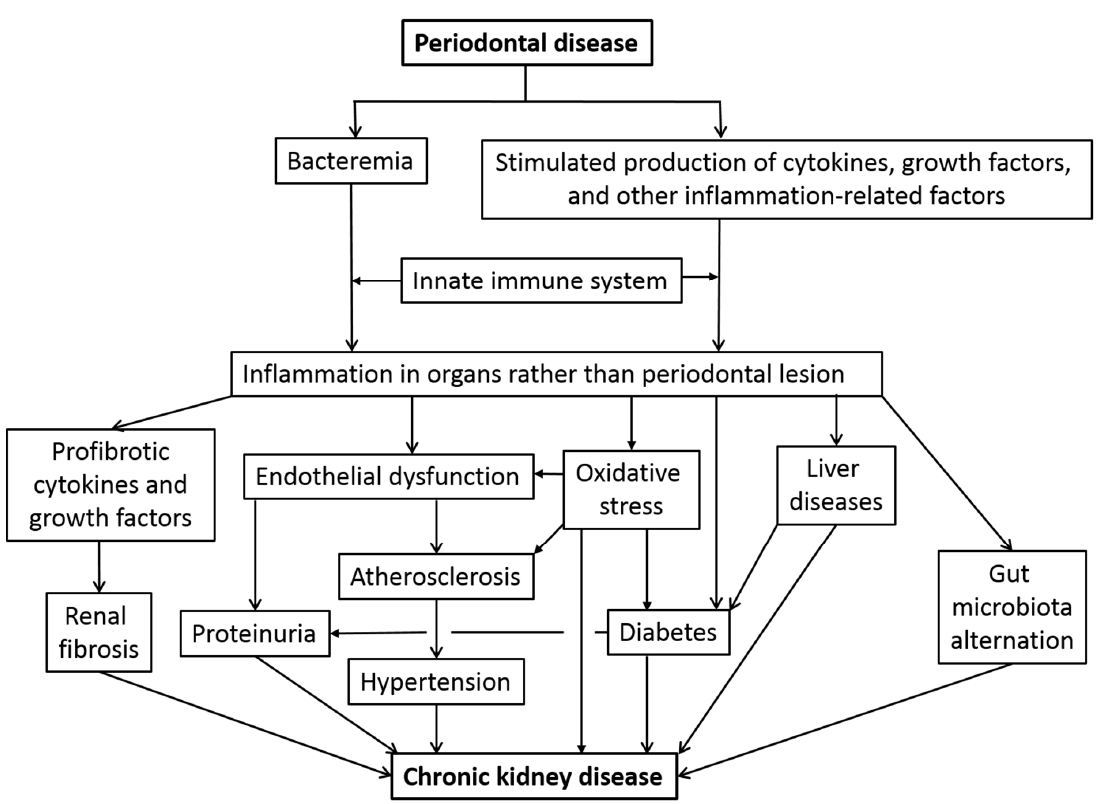
Figure 1. Impact of periodontal disease in the pathogenesis in chronic kidney disease.